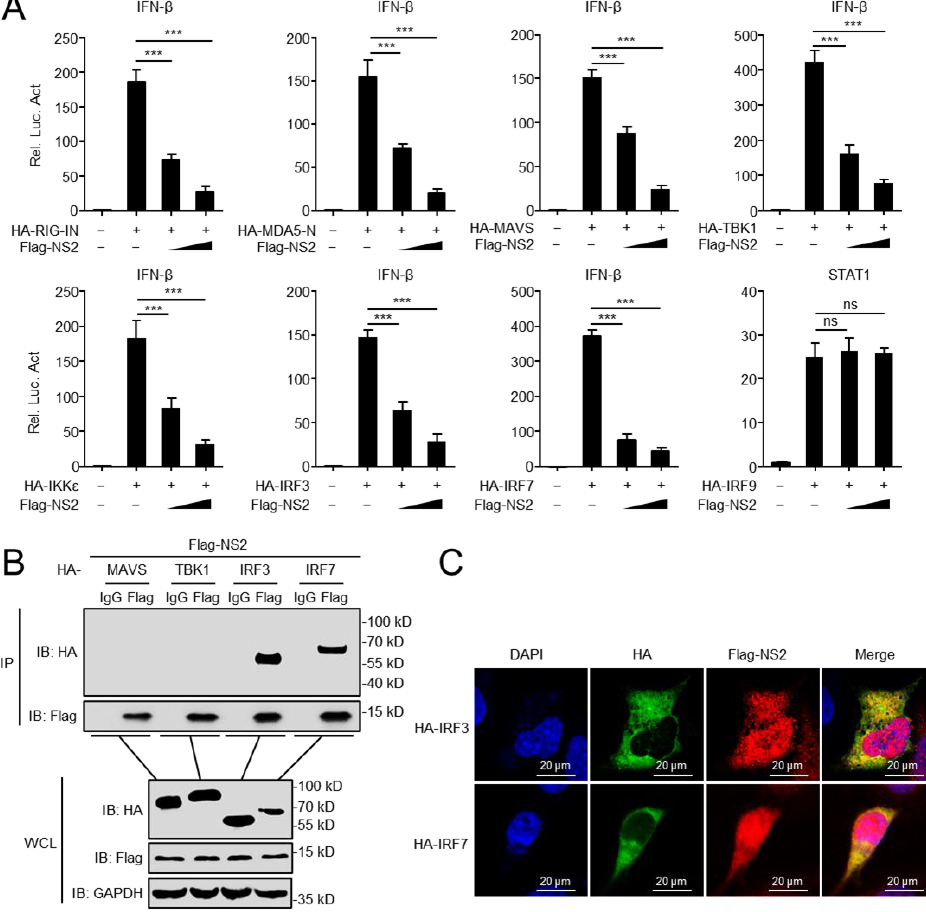
Figure 2. NS2 interacts with IRF3 and IRF7. ( A ) NS2 inhibits activation of the IFN- β promoter induced by RIG-IN, MDA5-Card, MAVS, TBK1, IKK ε , IRF3, and IRF7. HEK293 cells were transfected with indicated plasmids along with increasing amounts (0, 200 ng, and 400 ng/mL) of Flag-NS2 expression plasmids. The activation of STAT1-luciferase triggered by IRF9 was used as a negative control. Reporter assays were performed 24 h after transfection. ( B ) Overexpressed NS2 interacts with IRF3 and IRF7. HEK293 cells were transfected with indicated plasmids for 24 h. Then, Co-IP and immunoblotting analyses were performed using indicated antibodies. ( C ) NS2 co-localizes with IRF3 and IRF7 in the cytoplasm. U2OS cells were transfected with Flag-NS2 and HA-IRF3/IRF7 plasmid for 24 h, and then stained with Flag antibody or HA antibody and secondary antibodies. Nuclei were counter-stained with DAPI. Scale bar, 20 μm. The data shown represent three independent experiments ( p < 0.05 (*), p < 0.01 (**), p < 0.001 (***), ‘ns’ indicates no significant difference).